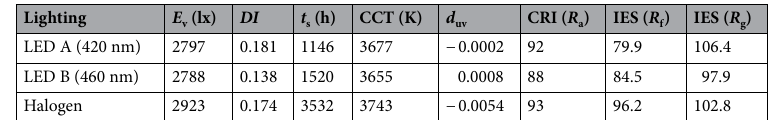
Table 1. Parameters of the lighting systems used. E v [lx]/damage index: DI /and critical duration of exposure in hours: t s . Discussed in methods section: CCT: correlated colour temperature in Kelvin (K)/CRI: colour rendering index in R a /Illuminating Engineering Society (IES) colour fidelity in R f /Illuminating Engineering Society (IES) gamut area index in R illuminance level in lux: